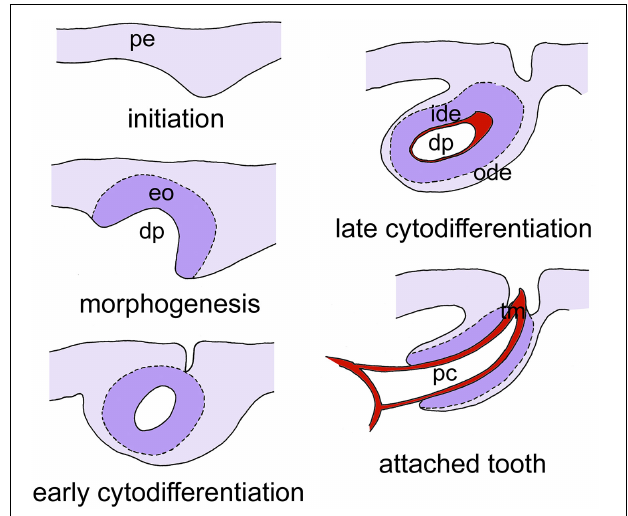
FIGURE 2 | Simplified scheme of tooth development in zebrafish, as exemplified for tooth 4V 1 . Tooth development proceeds through five successive, and partially overlapping stages, initiation, morphogenesis, early cytodifferentiation, late cytodifferentiation, and attachment. Only the epithelium is color-coded. Abbreviations: dp, dental papilla; eo, enamel organ; ide, inner dental epithelium; ode, outer dental epithelium; pc, pulp cavity; pe, pharyngeal epithelium; tm, tooth